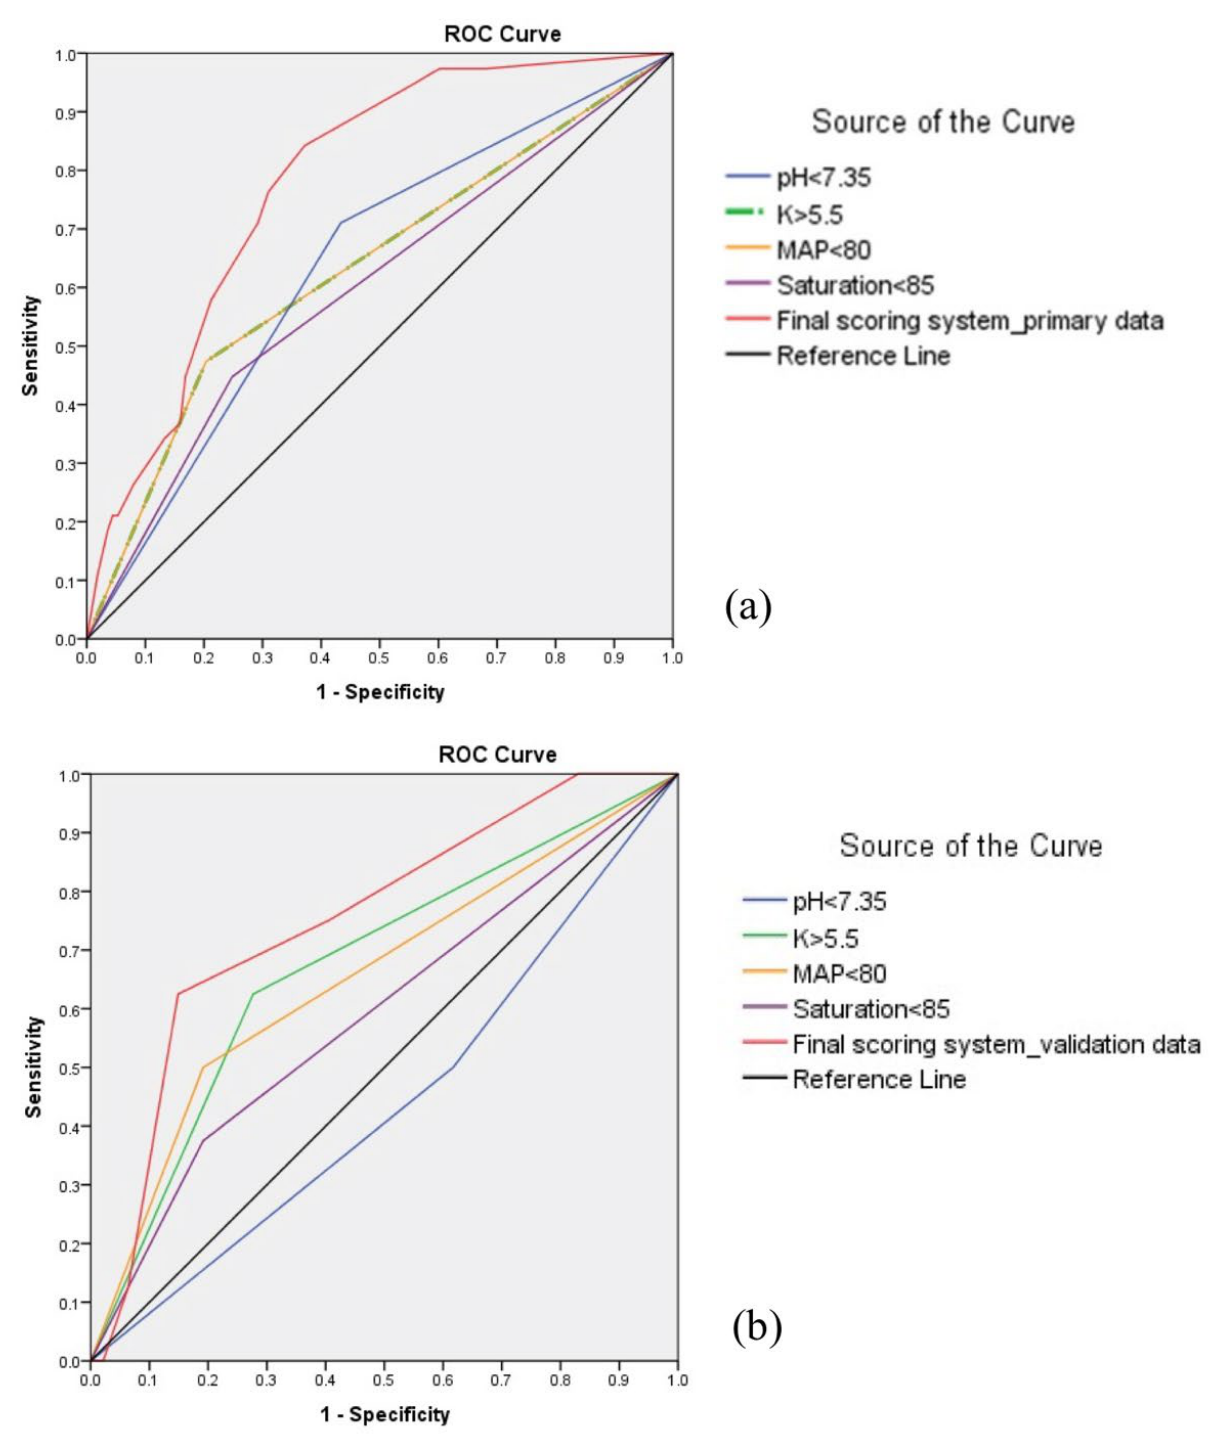
Figure 2. Association between predicting incidence of in-hospital cardiac arrest (IHCA) with different significant variables in each domain and combined model by using receiver-operating characteristic (ROC) curves. ( a ). Demonstration of the ROC curve to predict IHCA in the primary group collected between 2015 and 2018. The final scoring system (red line) had an area under the curve of 0.78. ( b ). Demonstration the ROC curve to predict IHCA in validation group collected in 2019. The same final scoring system (red line) had an area under the curve of